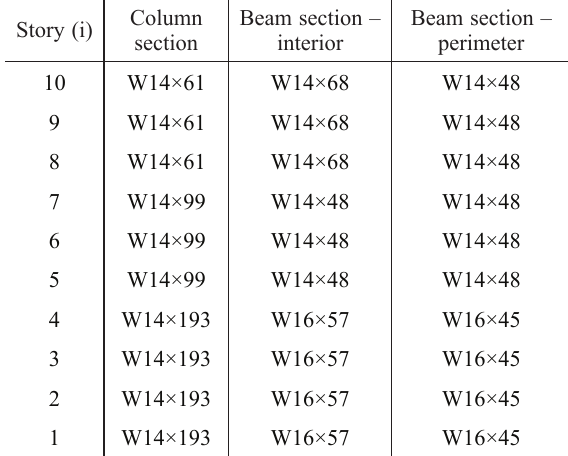
Table 1. Member data for horizontally irregular – Moment Resisting frame (MRf)